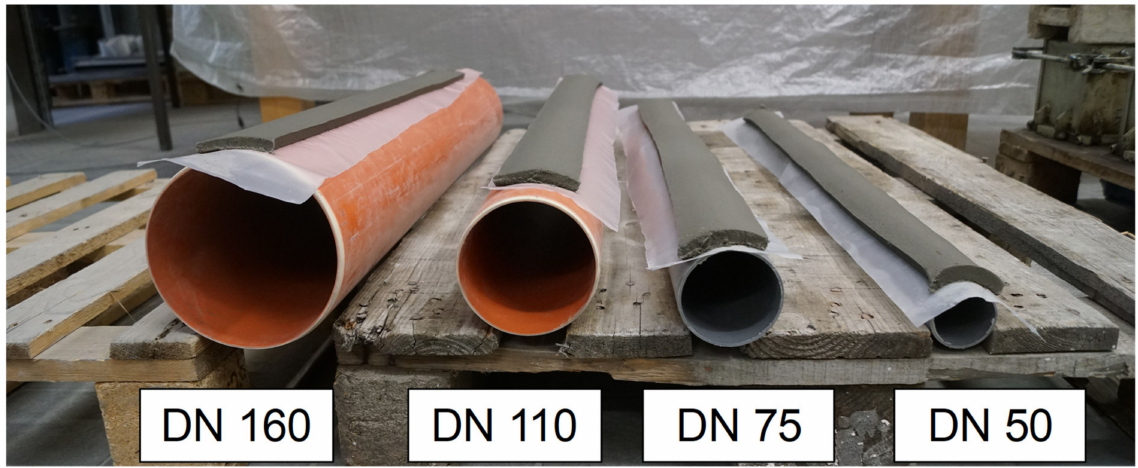
Figure 5. Pipes for shaping extruded components in the transverse direction from DN 160 to DN 50.